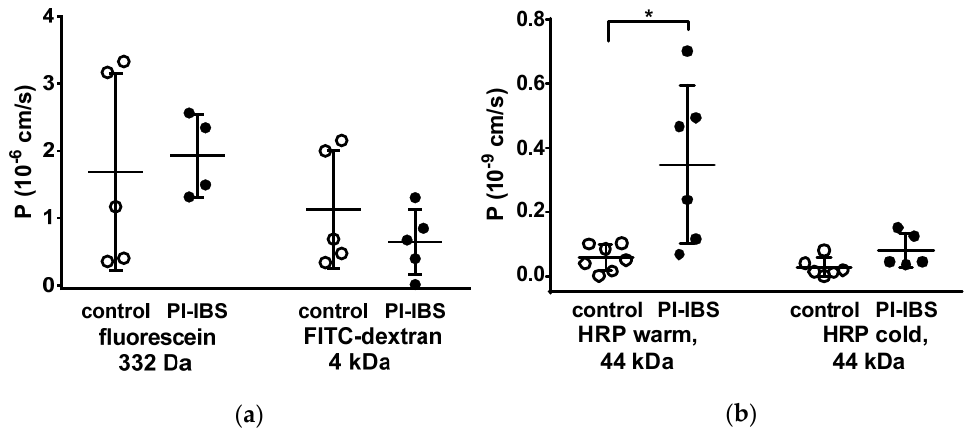
Figure 4. Macromolecule permeability in the sigmoid colon. Tracer fluxes across intestinal biopsy tissues were determined in Ussing chambers. Marker molecule fluxes of different sizes were meas- ured in mucosal-to-serosal direction with ( a ) 332 Da fluorescein and 4 kDa FITC-dextran, and ( b ) horseradish peroxidase (HRP, 44 kDa), either in warm conditions (37 °C, body temperature) or cold conditions (12 °C, causing endocytosis arrest). * p < 0.05, Student’s t -test, n = 6–7.